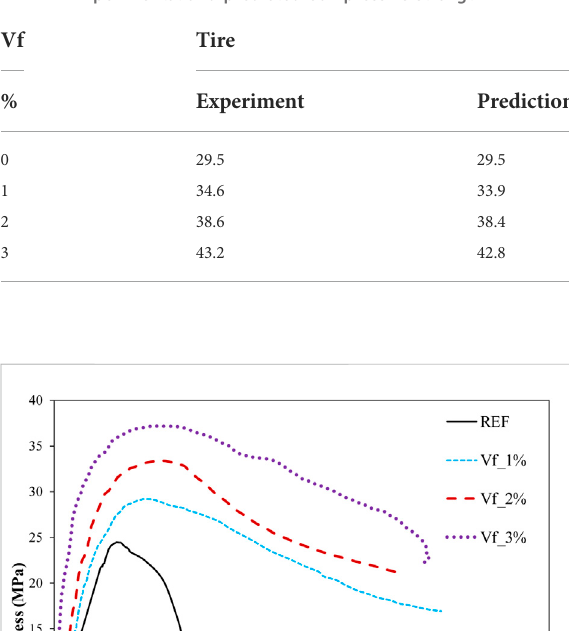
TABLE 2 Experimental and predicted compressive strength.